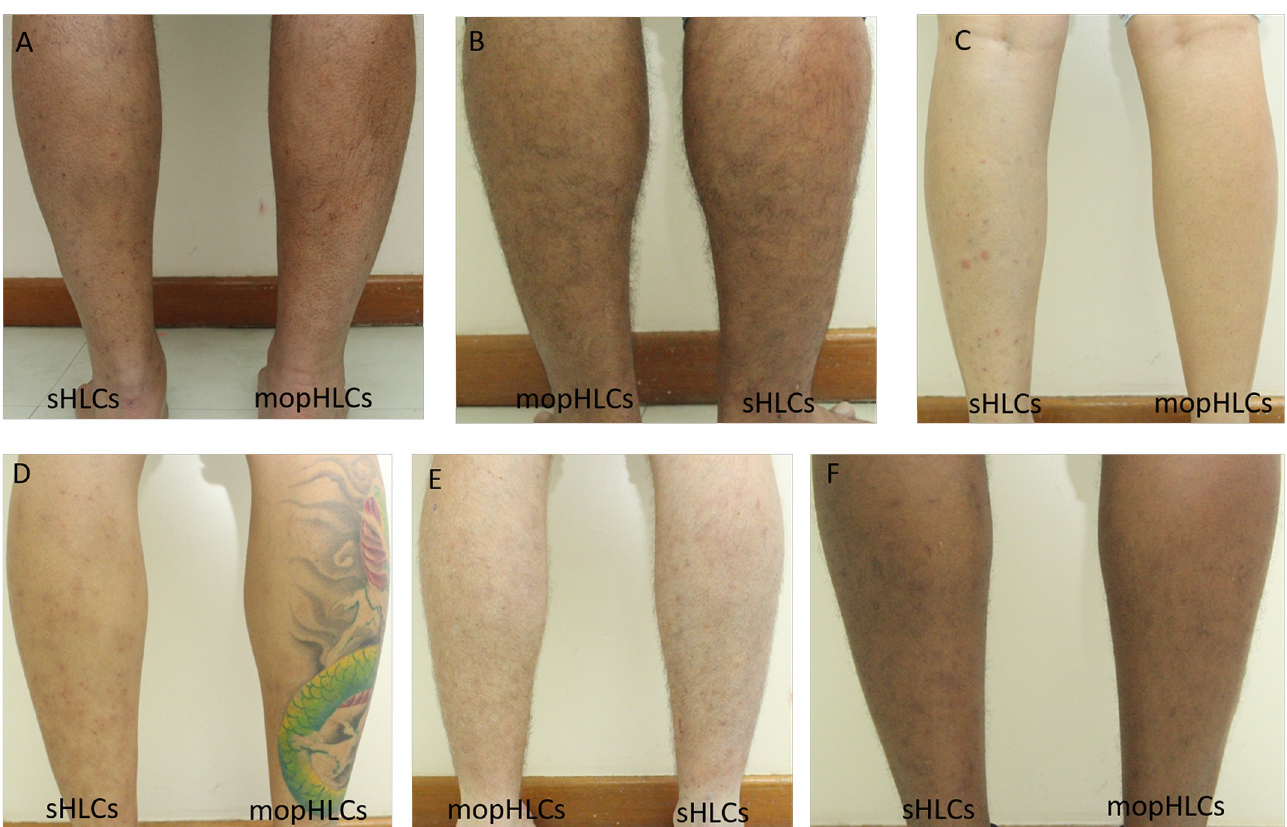
Fig 3. Shows photographs taken at the end of our “blind” bite-mark counting session on the 30th of October 2017. Vector collector legs (panels A-F) appear in the same sequence as they do in Fig 2 and are also labelled in the same way. The bite count data obtained on the day these photos were taken are shown in Table